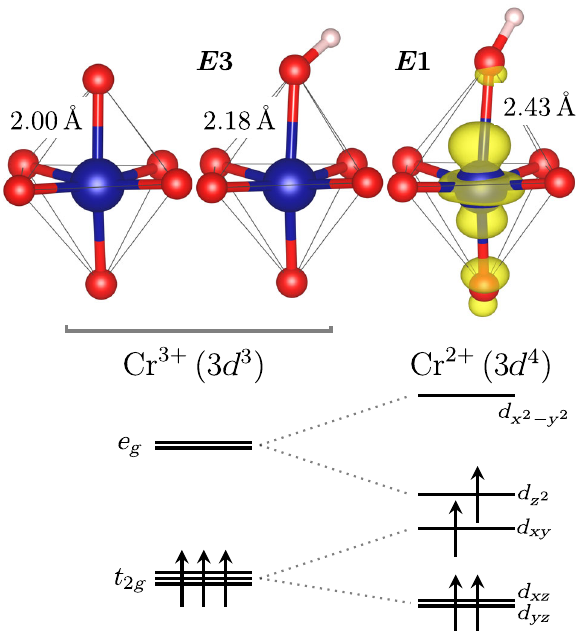
FIG. 10. Top: Octahedrally coordinated Cr atom (1) without the muon, with (2) the positive muon, and (3) a neutral-charge state formed by the muon and an extra electron localized on the Cr, changing its valence state from Cr 3 þ to Cr 2 þ . The presence of the positive muon removes some electron density from its associated Cr ─ O bond, causing elongation from 2.00 to 2.18 Å. The localization of the extra electron arising from the Coulomb attraction of the muon and the energy gain from the lattice distortion further elongates the Cr ─ O bond to 2.43 Å and leads to the formation of a charge-neutral muon-polaron complex. Bot- tom: Schematic representation of the crystal field. The occupation of the degenerate e orbital by the extra electron leads to a Jahn- g Teller distortion. The yellow isosurface shows the charge density of the topmost occupied band for the charge-neutral case, confirming that indeed the d level is z 2